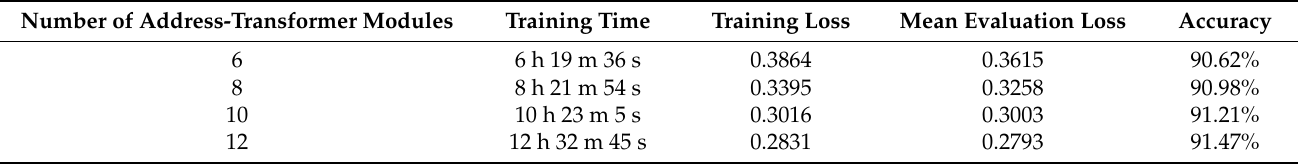
Table 4. Values for the ASM indicator for a different number of address-transformer modules.